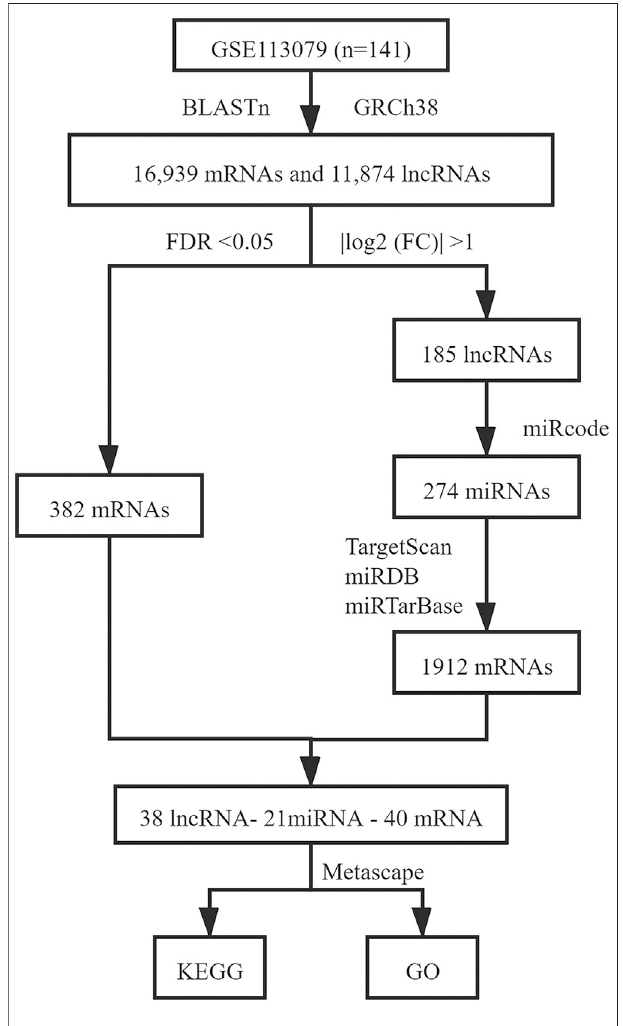
FIGURE 1 | ceRNA network construction